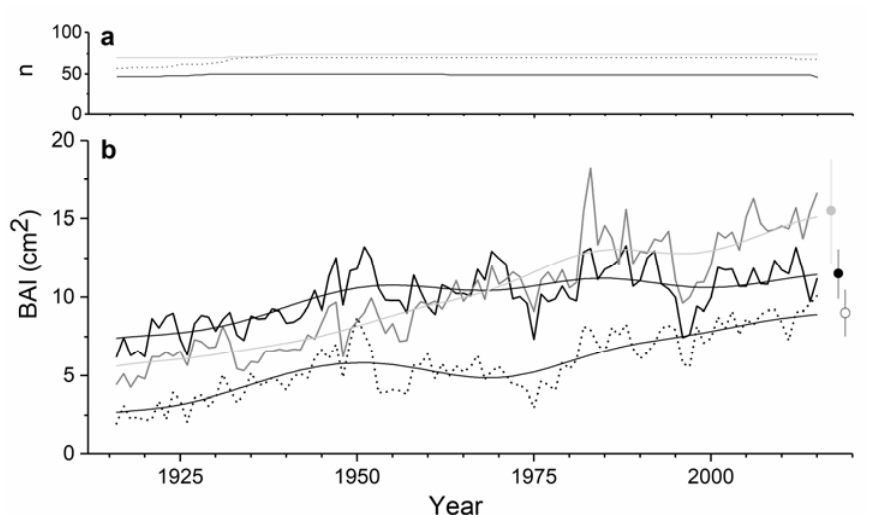
Figure 3. Sample depth ( a ) and basal area increment (BAI; b ) of selected tree species from subalpine sites ( Pinus cembra = continuous black line; Picea abies = continuous grey line; Larix decidua = dotted black line). Data were smoothed based on a fast Fourier transform low-pass filter (thin lines; number of points set to 10). Mean values ± standard error are indicated.